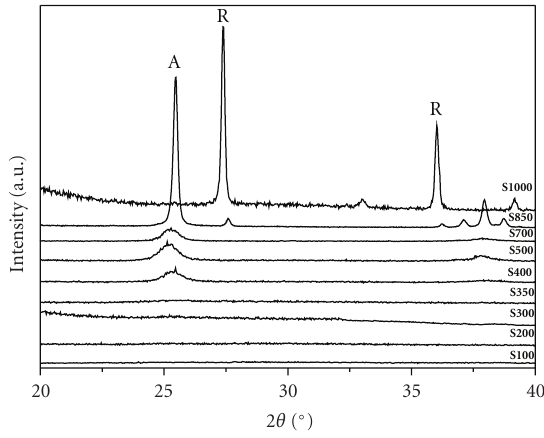
Figure 1: XRD patterns of the indicated